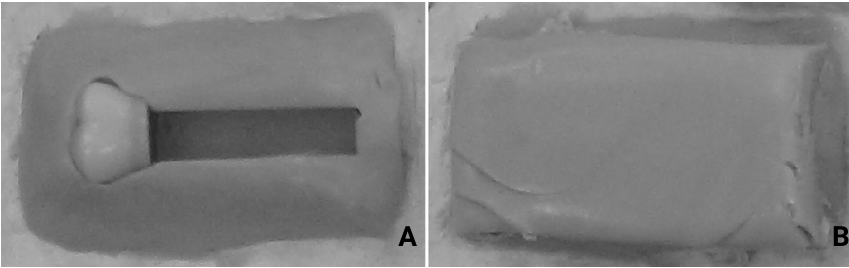
Figure 1. Initial preparation of samples. A) The artificial tooth was put into the silicone layer. B) Another layer of silicone covered the tooth. After stone set, the acrylic resin was included on the hole in silicon